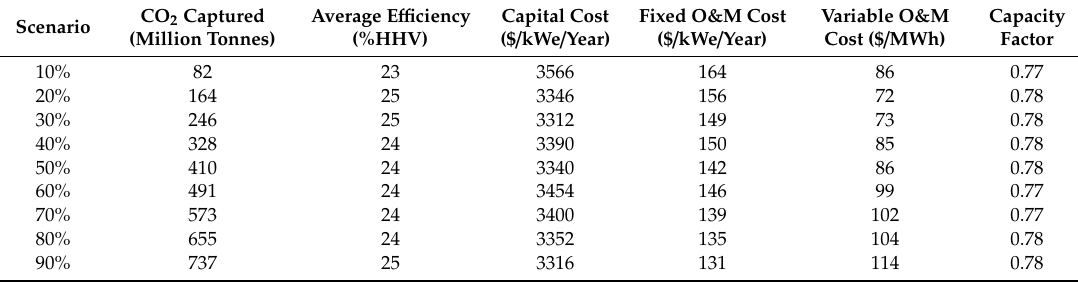
Table 5. Average e ffi ciency (%HHV), capital cost ($ / kWe), fixed O&M cost ($ / kWe / year), variable O&M cost ($ / MWh), and capacity factor for the IGCC 2040 conventional logistics